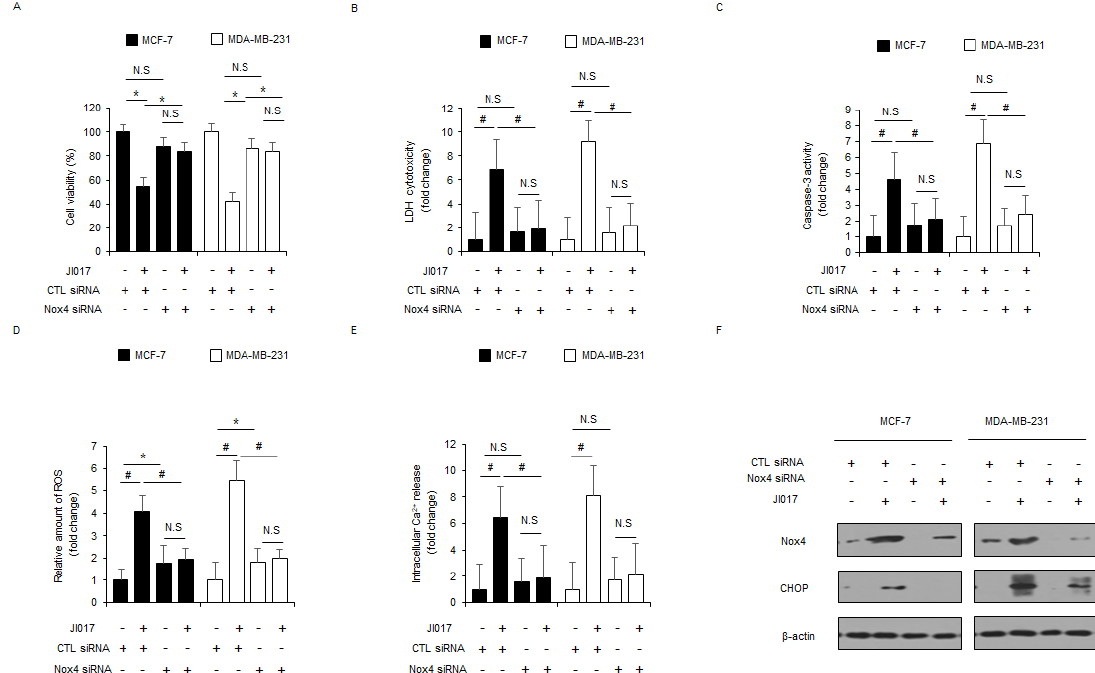
Figure 5. Suppression of Nox4 inhibits JI017-caused ER stress and cell death in breast cancer cells. ( A – F ) MCF-7 and MDA-MB-231 cells were transfected with Nox4 siRNAs and treated with JI017 (300 µg/mL, 24 h). Next, WST-1 assay, LDH cytotoxicity assay, caspase-3 activity assay, intracellular ROS assay, and intracellular Ca 2+ assay were performed along with Western blot analysis for Nox4 and CHOP; *, p < 0.05, #, p < 0.01. β-actin was used as the protein loading control.